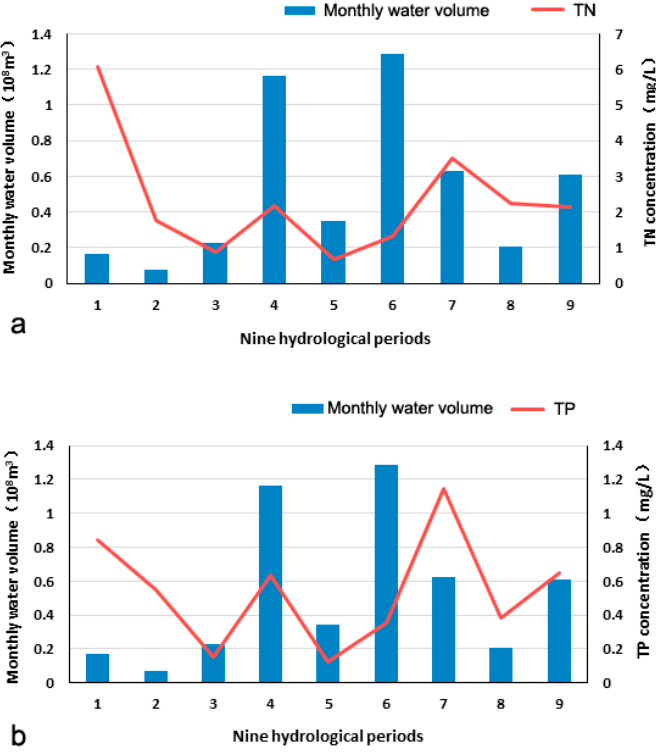
Figure 5. Relationships between monthly water volume and TN ( a ) and total phosphorus (TP) ( b ).